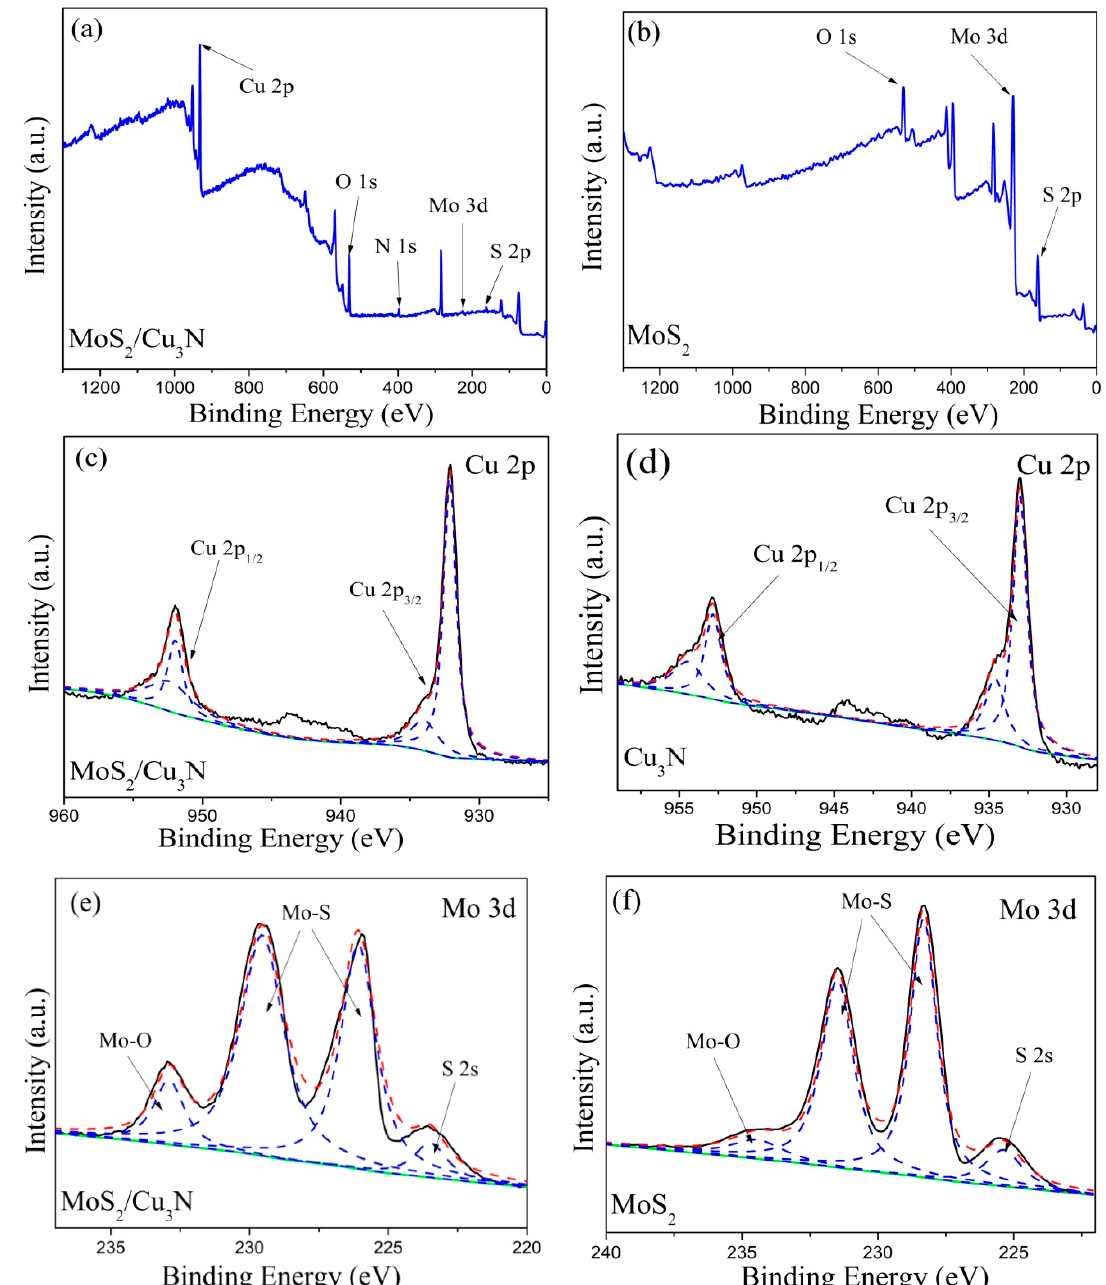
Figure 4. XPS spectrum: ( a ) total spectrum of the Cu 3 N / MoS 2 heterojunction, ( b ) MoS 2 total spectrum, ( c ) Cu 2p peak fitting in the Cu 3 N / MoS 2 heterojunction, ( d ) Cu 2p peak fitting in the Cu 3 N layer, ( e ) Mo 3d peak fitting in the Cu 3 N / MoS 2 heterojunction, and ( f ) Mo 3d peak fitting in the MoS 2 layer.